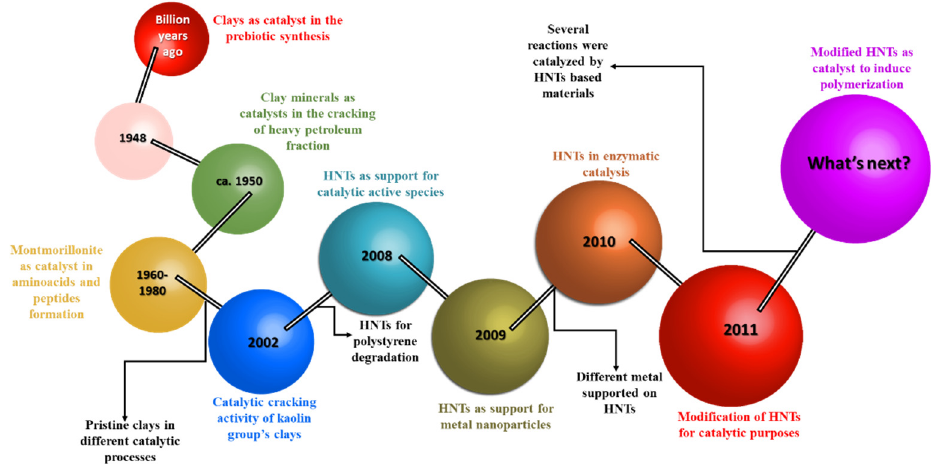
Figure 1. A brief timeline for the use of clay minerals as catalyst and in particular on the application of halloysite nanotubes (HNTs).